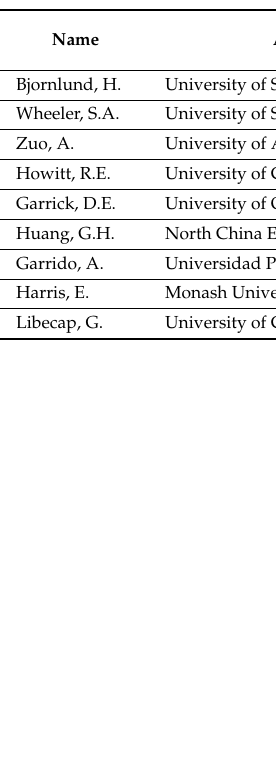
Table 9. Most prominent countries in the production of articles on the Water